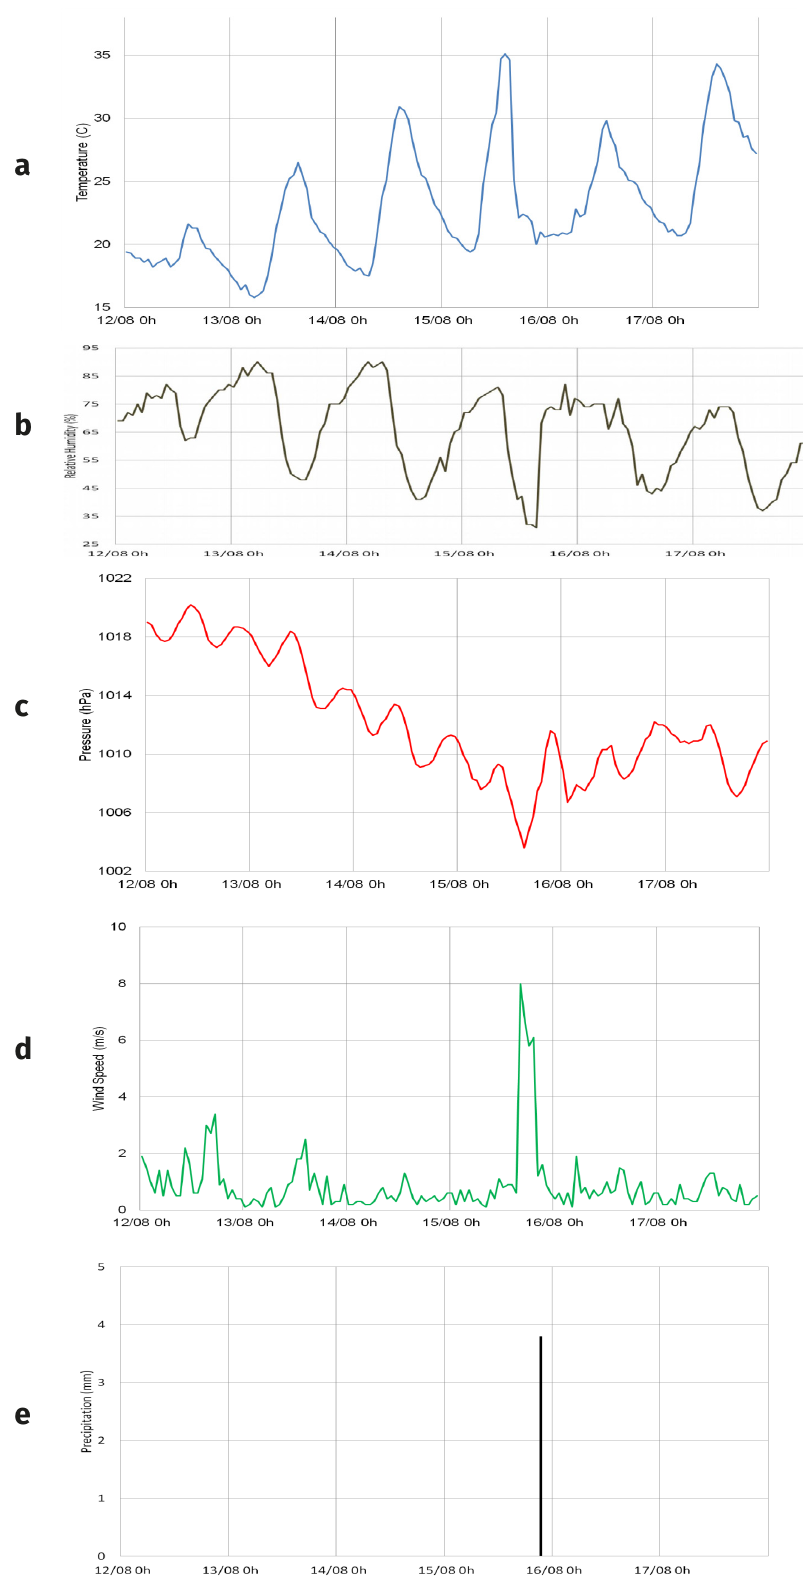
Figure 2. Time series with hourly data of, a air temperature (°C), b relative humidity (%), c sea-level pressure (hPa), d maximum wind speed (m s -1 ) and e cumulative precipitation (mm) measured by the AWS at